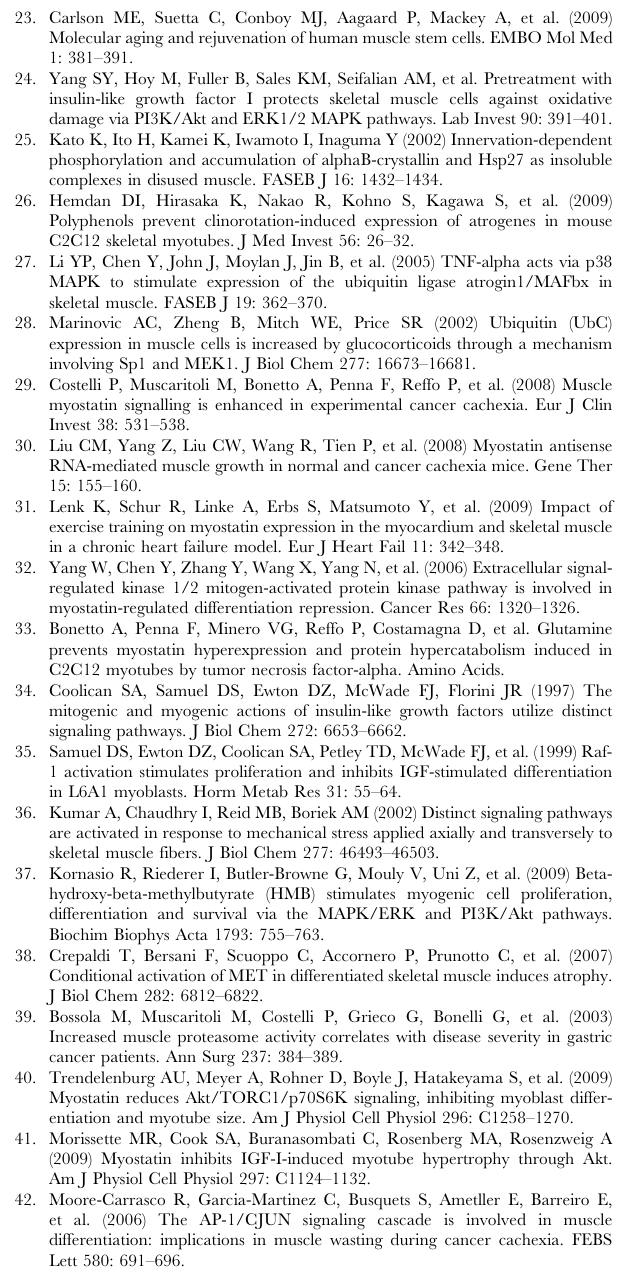
(n =8) and controls (n =6), treated or not with PD (1 mg/kg), expressed as percentage of controls. Data are means 6 SD.